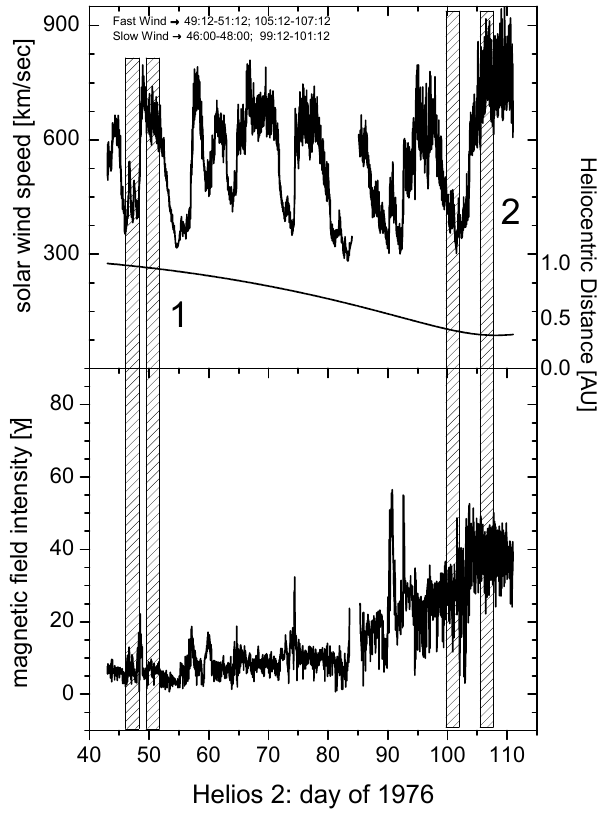
Fig. 1. Top panel: solar wind speed profile versus time as recorded during the first solar mission of Helios 2. The solid, smooth line represents the heliocentric distance of the s/c which varied between 0.97 and 0.29AU. Bottom panel: magnetic field intensity profile versus time. The whole interval was characterized by the presence of only one shock around day 90. Vertical hatched regions identify time intervals chosen for this analysis. There are two high speed intervals located in the trailing edge of two corotating streams and two low speed intervals ahead of them.